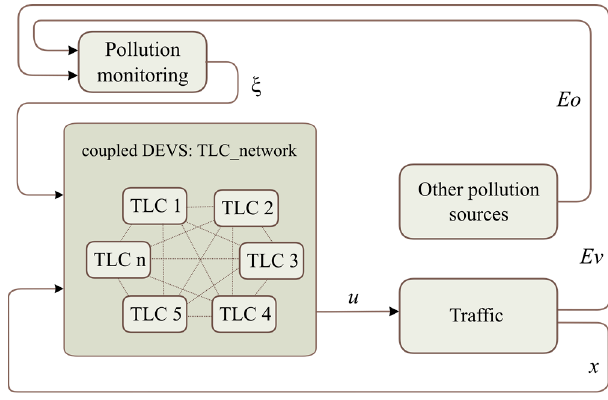
Figure 3. Structure of DEVS models.